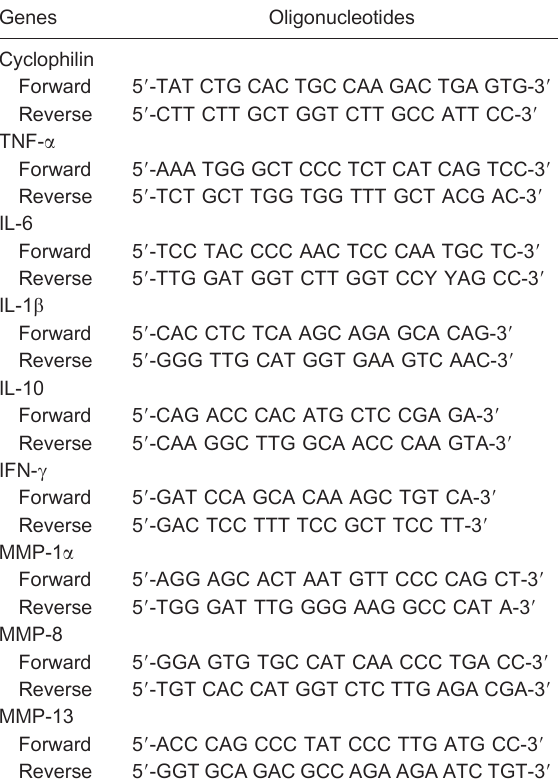
Table 1. Genes and oligonucleotides used in real-time quantita- tive reverse transcription polymerase chain reaction (qRT-PCR). Genes